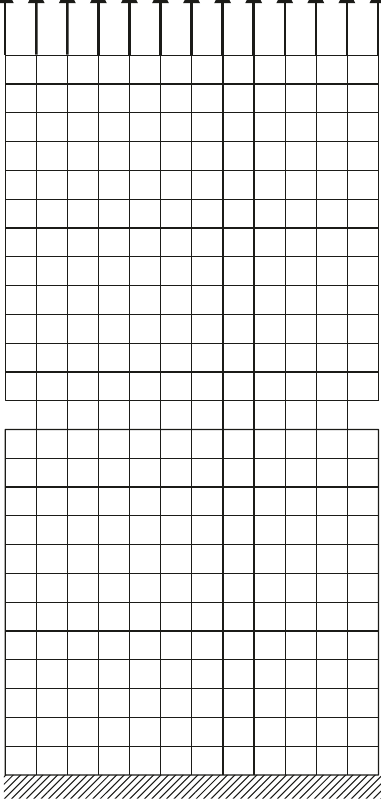
Figure 9: FE mesh for the DEN concrete